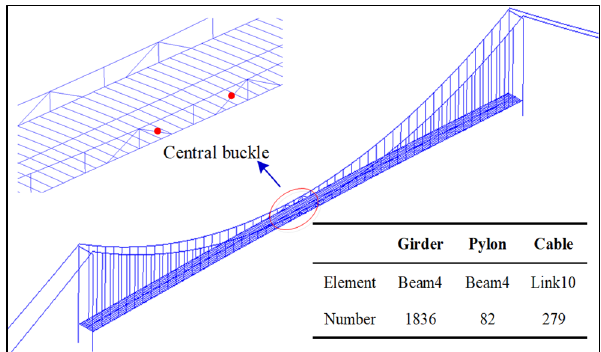
Figure 4. Bridge FE model.